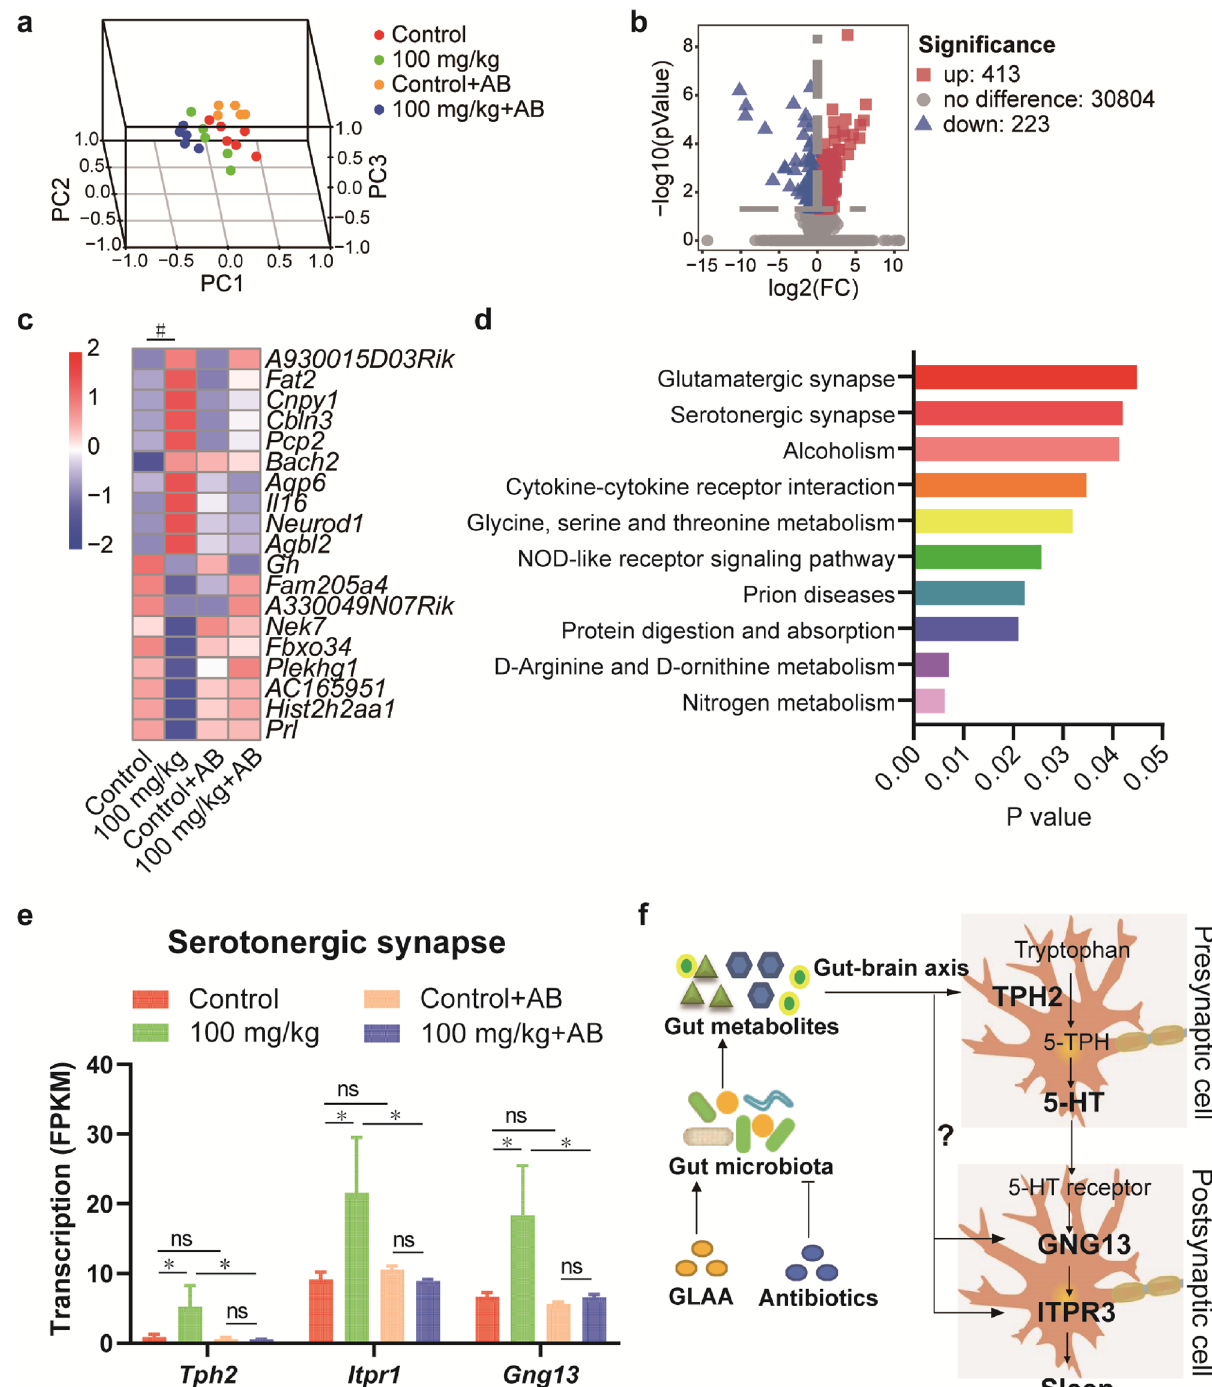
Figure 5. Gavage administration of GLAA regulated the serotonergic synapse pathway in the hypothalamus. ( a ) PCA score plots of transcriptome profiles of these four groups. ( b ) Volcano map of gene transcription after administration of GLAA. ( c ) Gene transcription was altered after GLAA administration in the four groups ( p adj > 0.05). ( d ) KEGG pathways altered in the hypothalamus after administration of 100 mg/kg GLAA ( p > 0.05). ( e ) Gene transcription in the serotonergic synapse pathway was altered after GLAA administration in the four groups. ( f ) General view of the effects of GLAA on sleep promotion. The data are calculated from 5–6 samples per group. The data are shown as the means ± SEMs; * p < 0.05, # p adj < 0.05, ‘ns’ indicates that the difference is not significant. The images a, b and c are generated by R package “scatterplot3d”, “ggplot2” and “pheatmap” respectively, the image f is generated by ScienceSlides Suite, and the others are generated by GraphPad Prism 8. GLAA the acidic part of the alcohol extract of G. lucidum mycelia, AB antibiotics, PCA principal component analysis, 5-HT